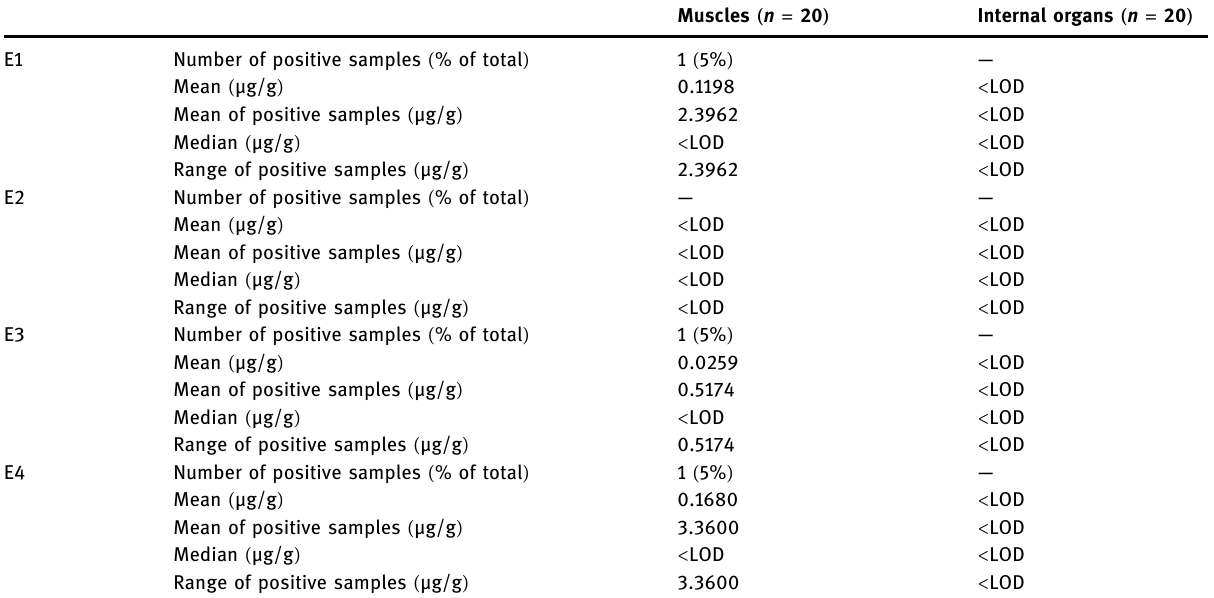
Muscles ( n = 20 ) Internal organs ( n = 20